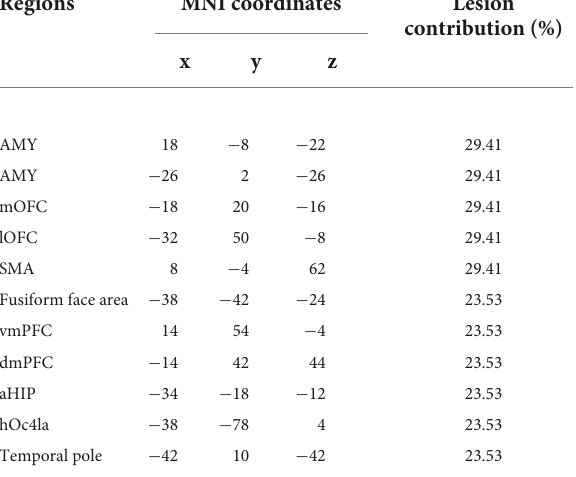
TABLE 1 Results from the lesion-based meta-analytic connectivity modeling.